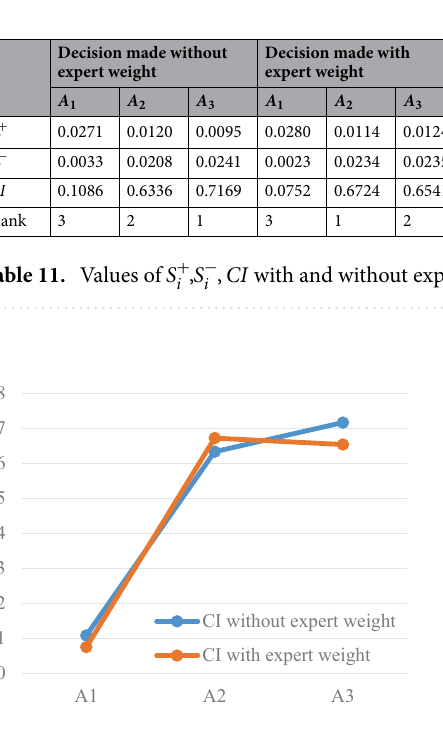
Figure 8. CIs of alternatives with and without expert